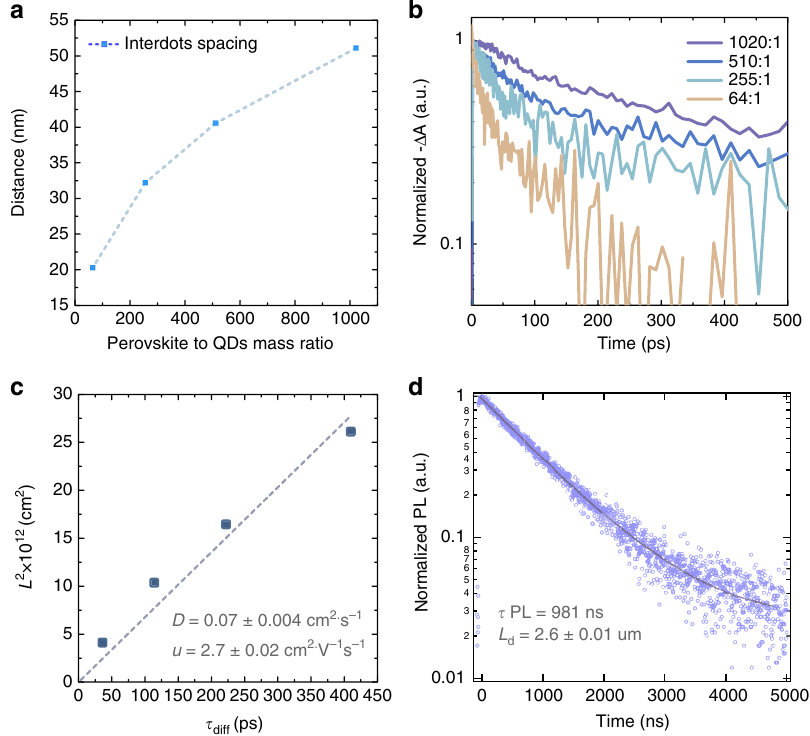
Fig. 4 3D diffusion-quenching measurement on MAPbBr 3 single crystals. a Inter-dot spacing tuning via controlling the quantum dot concentration from 64:1 to 1020:1 (mass ratio between perovskite and QDs, QD radius = 2.5 nm). b Transient absorption dynamics at perovskite bleach with different diffusion distance (limited by inter-dot spacing). c Fitting of diffusion coef fi cient and carrier mobility of MAPbBr 3 single crystals. d Carrier lifetime and diffusion length calculation of MAPbBr 3 single